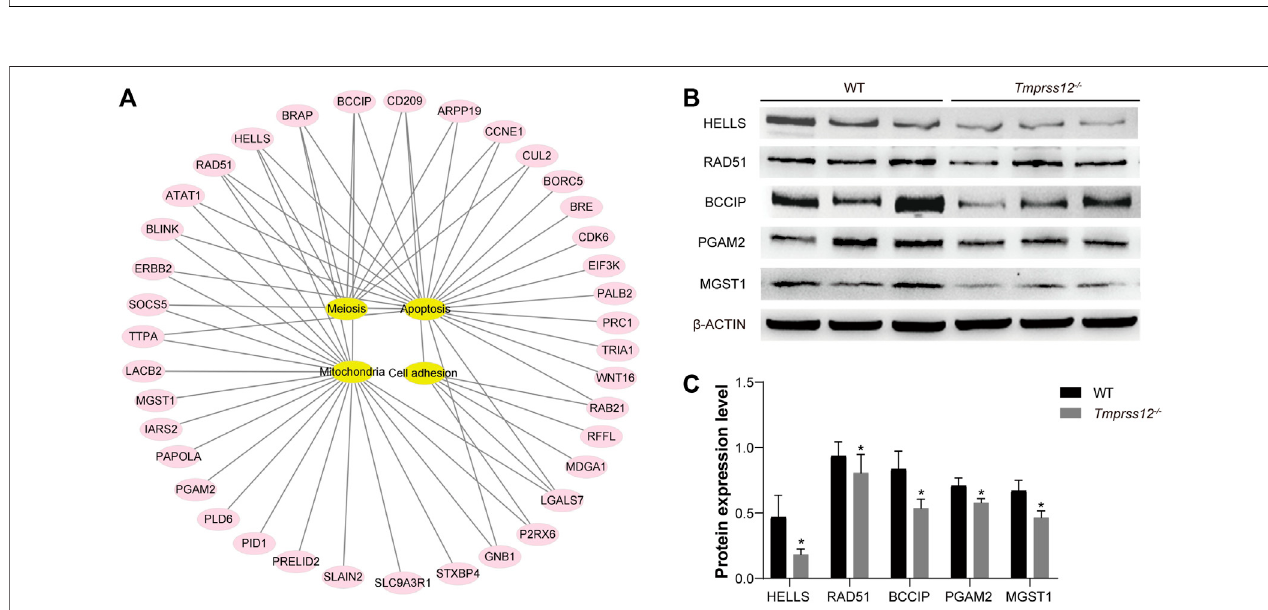
FIGURE 7 | Mitochondrial development in testicular spermatids was impaired in Tmprss12 knockout mice. (A) Western blot of special molecules involved in spermiogenesis from the testes of WT and Tmprss12 − / − mice. β -ACTIN was used as an internal control. (B) Grey intensity analysis showing that the expression level of KLC3 decreased in Tmprss12 − / − mice ( n = 3). Data are the mean ± s.d. p p < 0.05.